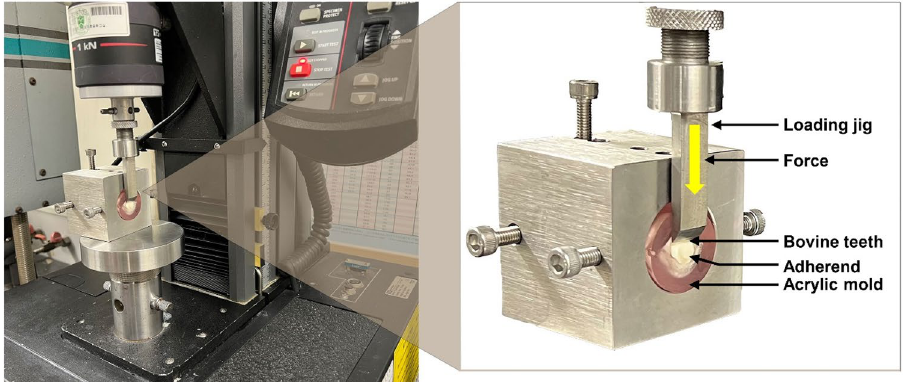
Figure 2. Schematic representation of the shear bond strength